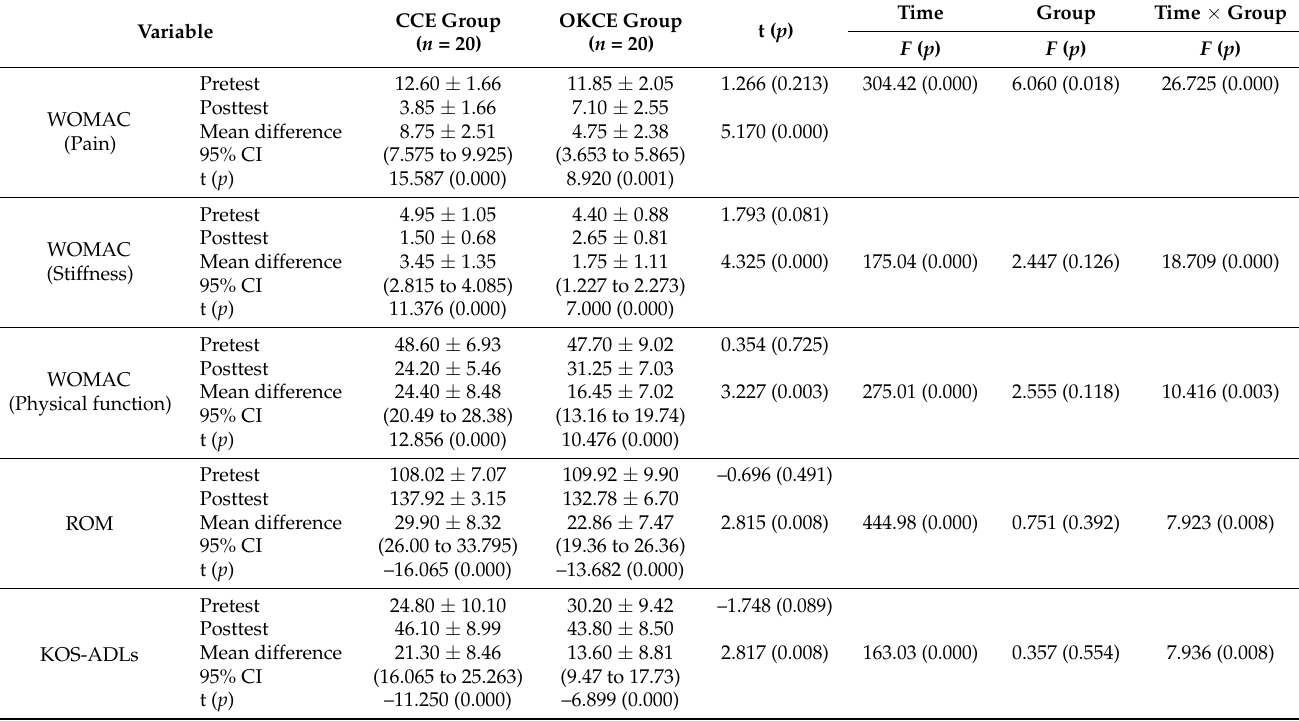
Table 4. Comparisons of physical function.